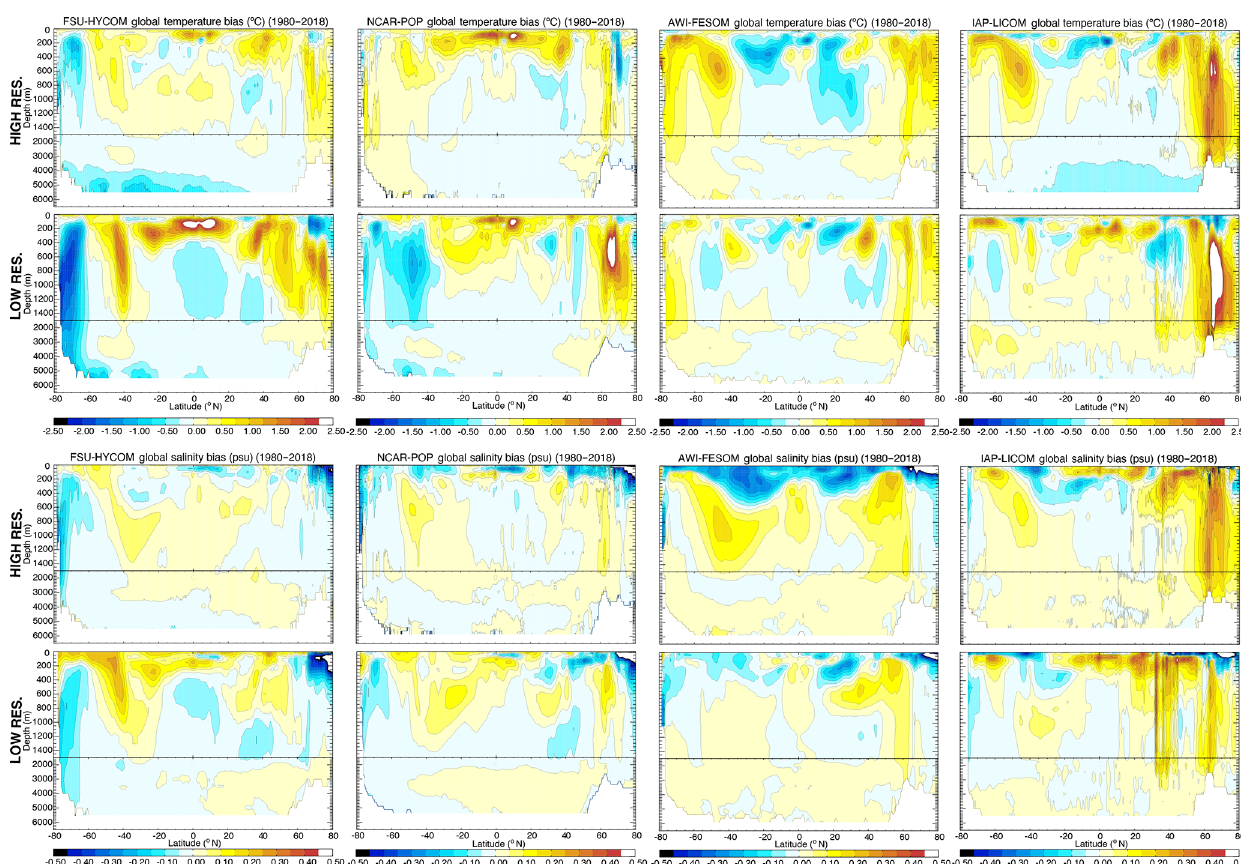
Figure 11. Global zonal temperature ( ◦ C) and salinity (psu) difference with the climatology used to initialize the model.